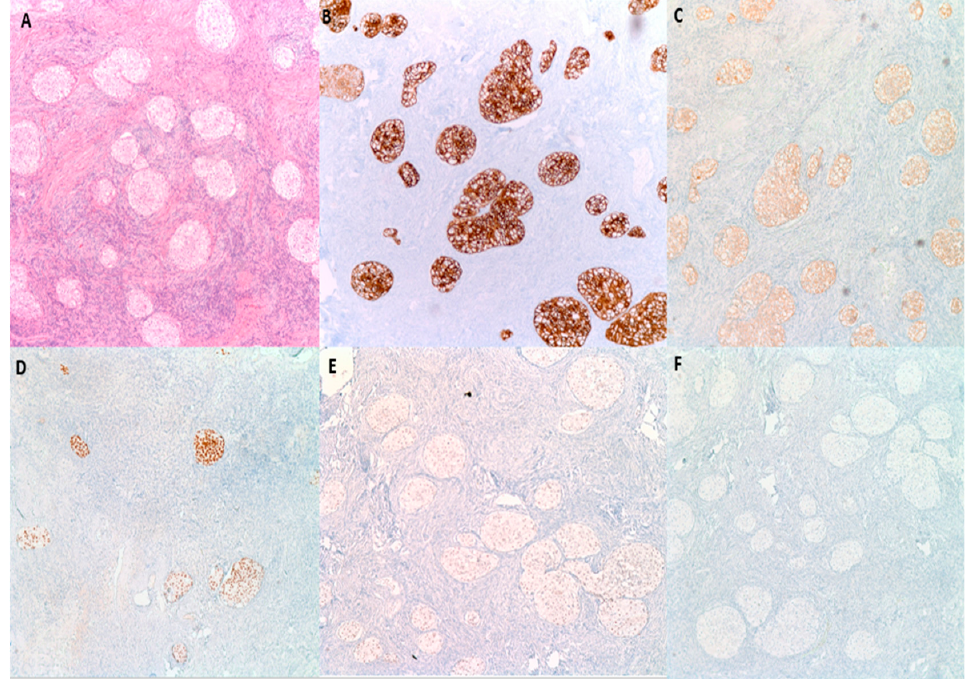
Figure 5. Immunohistochemical characteristics of benign BTs. ( A ) H&E microscopic image of a benign BT. ( B ) Tumor cells are diffusely and strongly positive for CK7. ( C ) CK20 shows moderate intensity staining. ( D ) P63 is diffusely and strongly positive. ( E ) GATA3 shows moderate intensity nuclear reactivity. ( F ) PAX8 is negative (100× magnification).